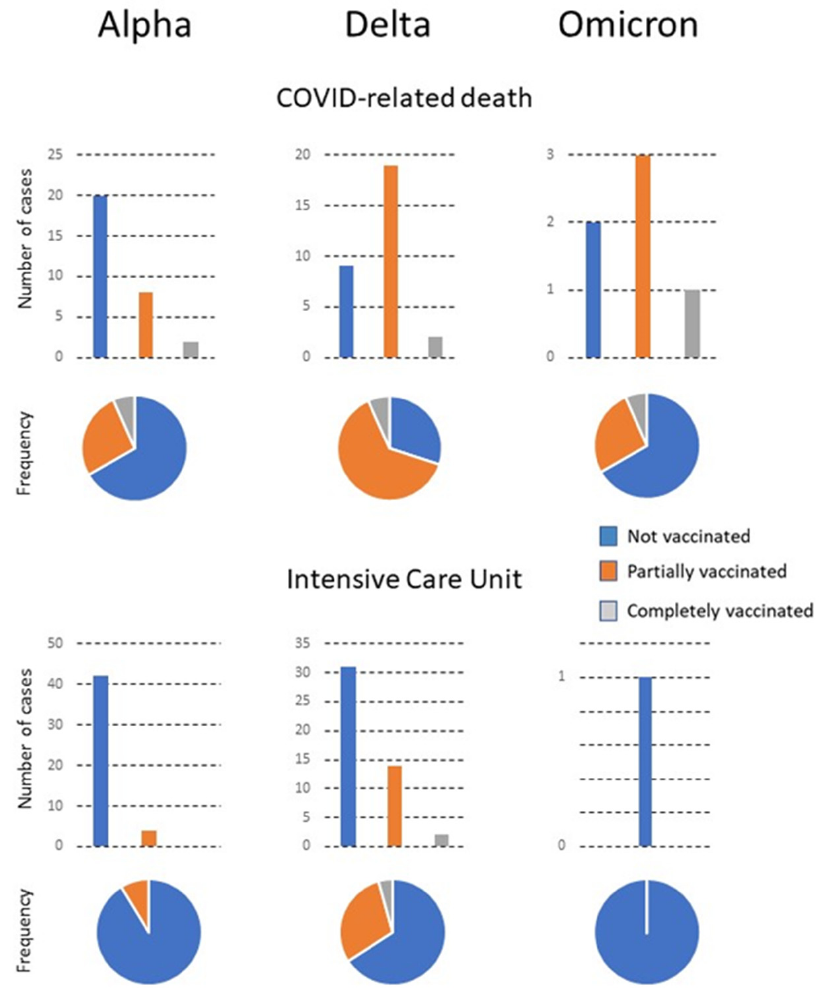
Figure 2. The number of patients with COVID-related death or requiring admission to the Intensive Care Unit (ICU). Numbers are shown in relation to the predominant variant, the vaccination status, and the frequency of each status with respect to the total number of infected individuals.